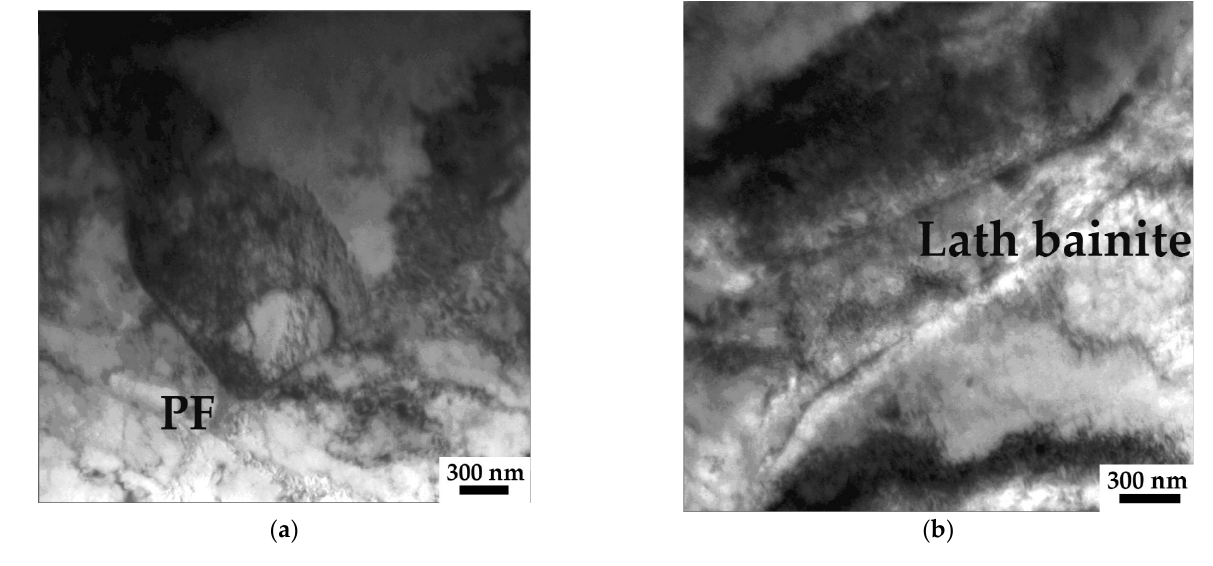
Figure 5. Bright field TEM micrographs illustrating the microstructure of the BM at location “1” in Figure 1a. ( a ) Polygonal ferrite (PF) containing high density of motile dislocations and ( b ) bainite plates containing high density of tangled dislocations.